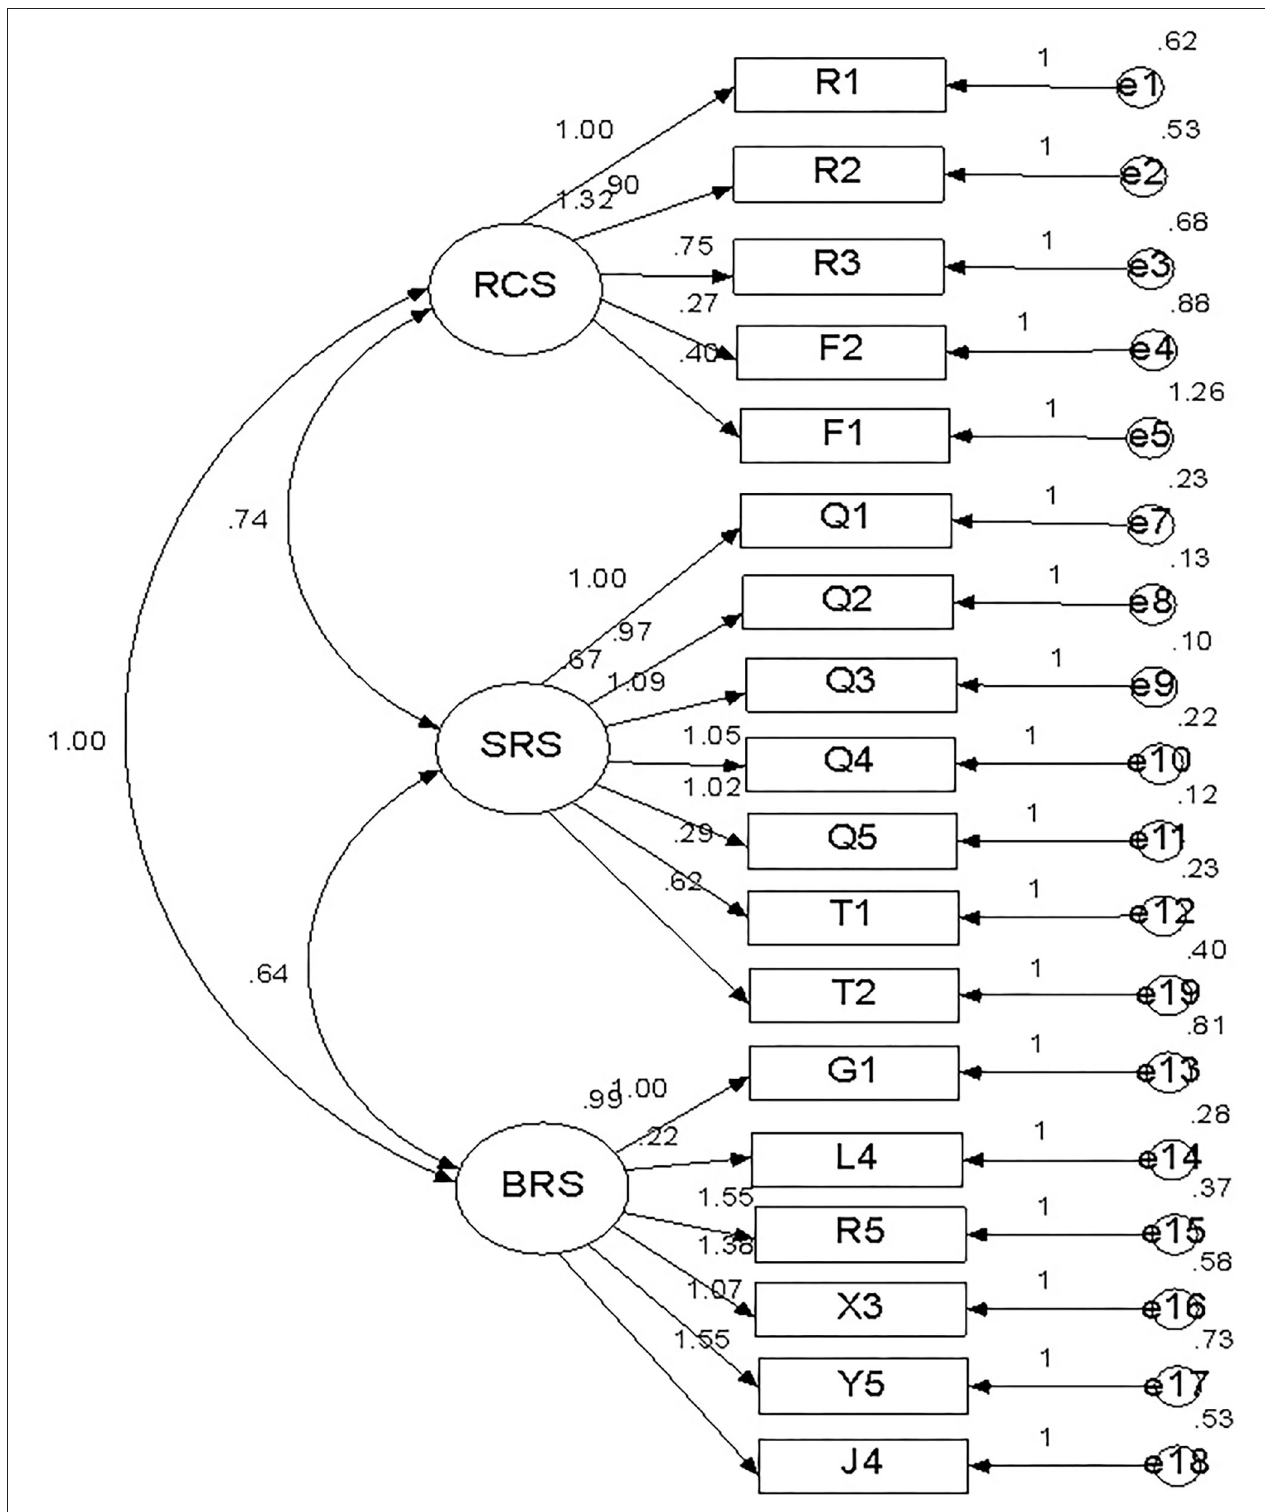
FIGURE 1 | Fit indexes of the 3-subscale model with 18 items.